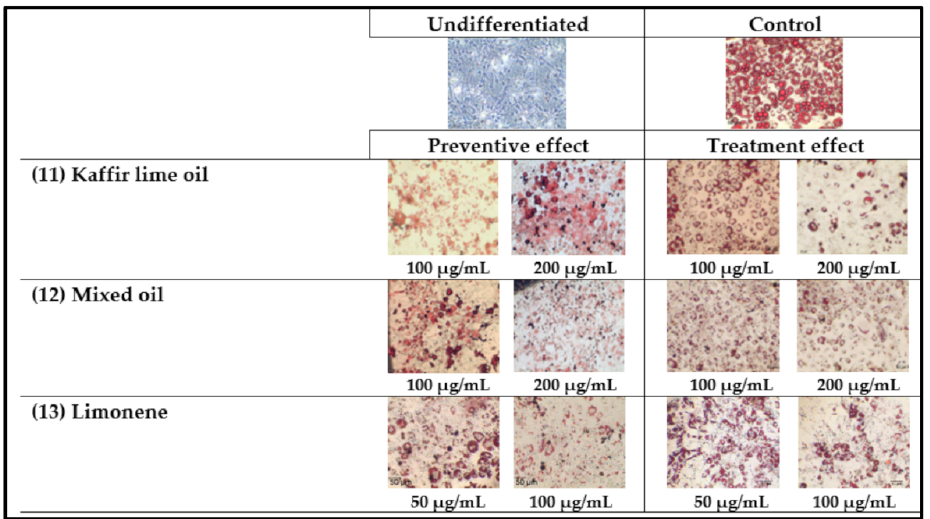
Figure 3. Representative photographs (20 × ) of 3T3-L1 adipocytes stained with Oil Red O after treatment with the essential oils, extracts and limonene in comparison with undifferentiated and control cells. To study the preventive effect, the mature adipocytes were treated with samples (1–13) on days 3, 5 and 7 after the initiation and the oil red O staining was conducted on day 9. For treatment effect, the samples were incubated with the mature adipocyte on day 9 and their effects were measured on day 10. Notably, 1 mM (18.3 µ g/mL) caffeine and 0.1 mM (194.2 µ g/mL) adrenaline were used as positive controls.